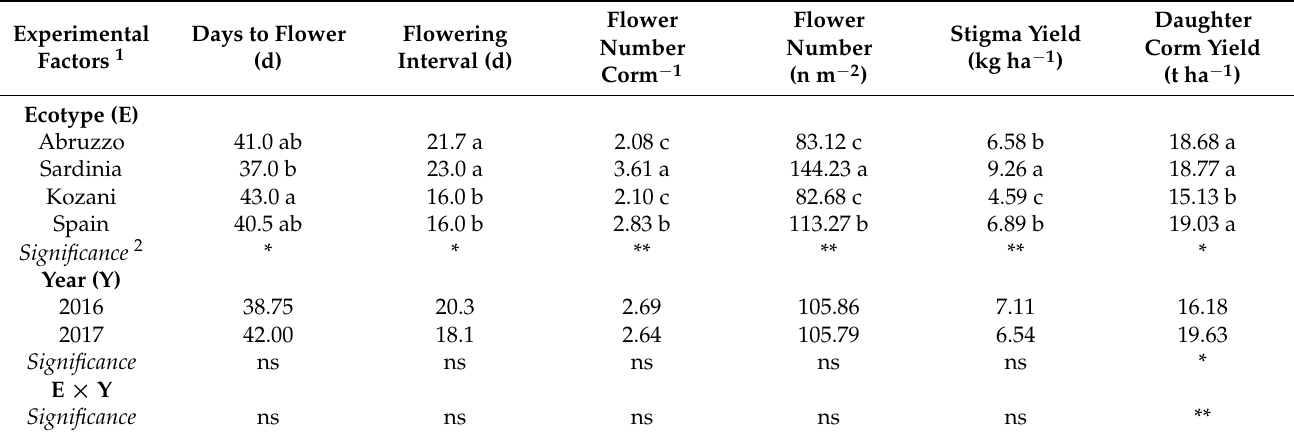
Table 4. Phenological and productive traits related to ecotype (E), year (Y) and their interaction. Experimental